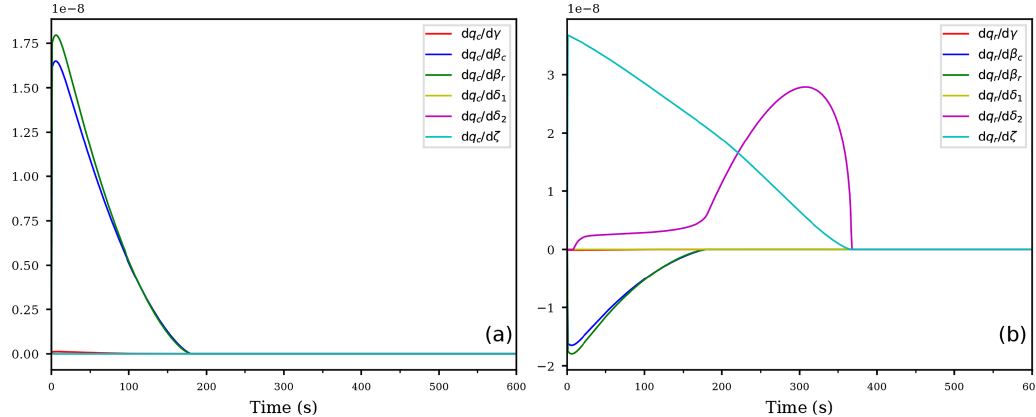
Figure 7. As in Fig. 6, but for the derivatives of q c (a) and q r (b) with respect to the exponents.